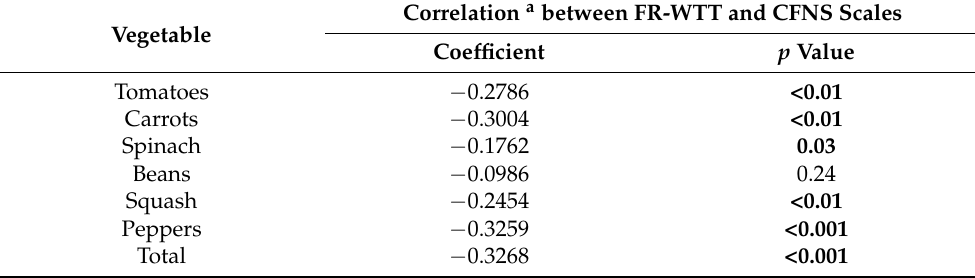
Table 3. Evaluation of correlations a between Farfan-Ramirez willingness-to-try (FR-WTT) vegetables and the Child Food Neophobia Scale (CFNS). Correlation a between FR-WTT and CFNS Scales Vegetable Coefficient p Value Tomatoes − 0.2786 <0.01 Carrots − 0.3004 <0.01 Spinach − 0.1762 0.03 − 0.0986 0.24 −